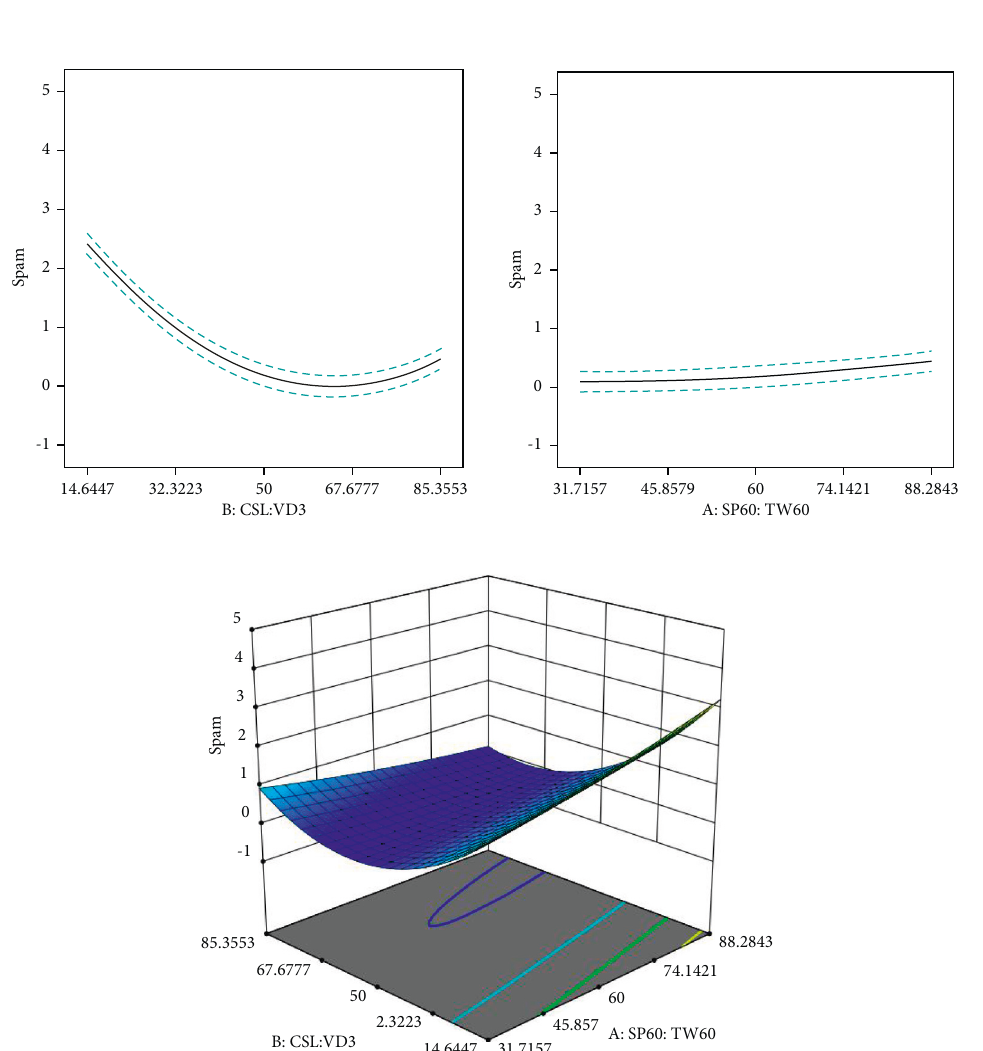
Figure 2: Effects of Span 60: Tween 60 and cholesterol: vitamin D3 ratio on span of niosome.